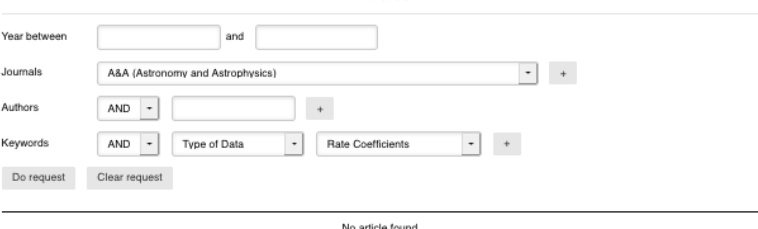
Figure 3. Query Interface for the bibliography associated with the numerical data. There is a search by year, journal, authors, and keywords. The search by keywords is possible because of the “keywords” metadata of Table